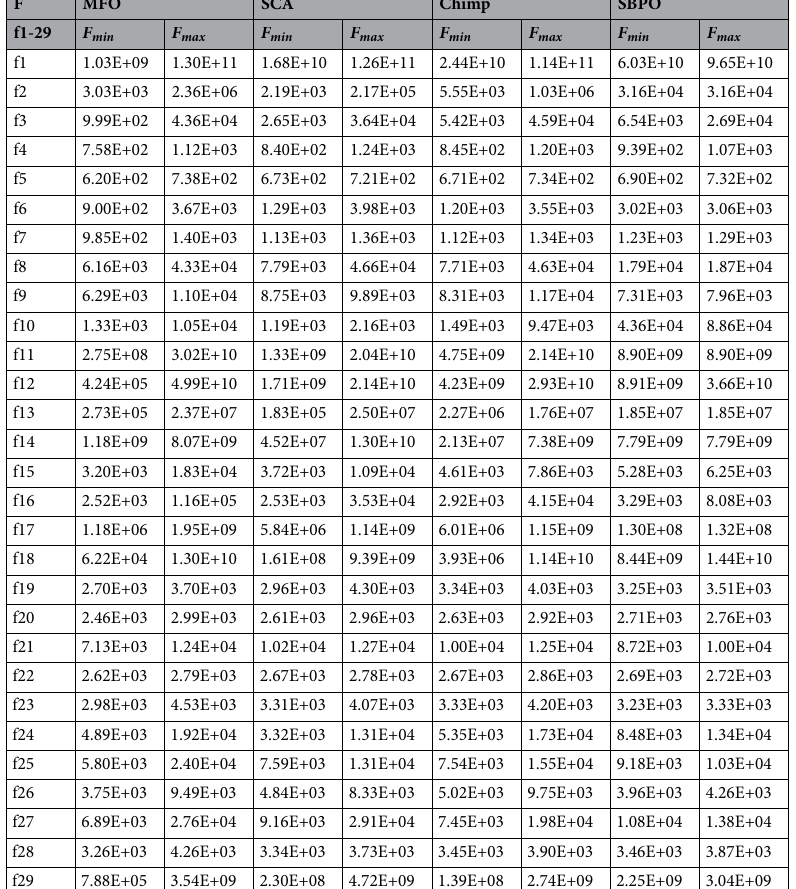
Table 3. Results of Optimizers on Uni-modal, Simple Multi-modal test